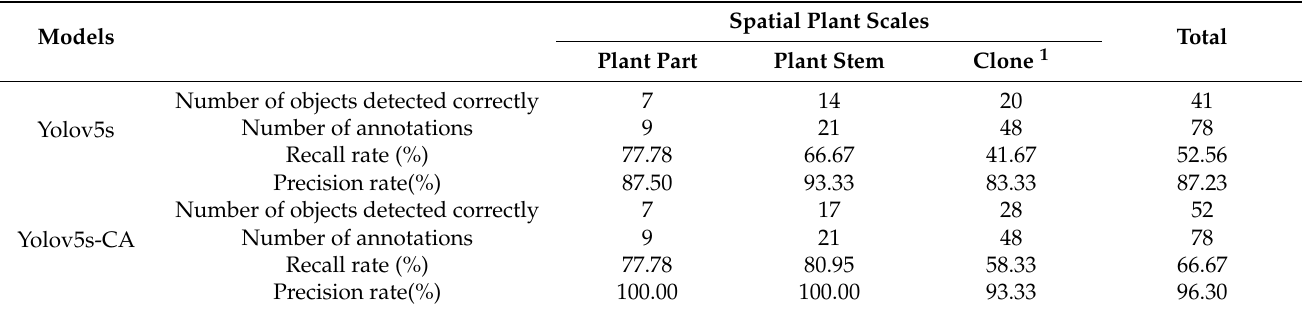
Table 5. Detail detection results of mummy berry disease at different spatial